Question: Write a single sentence explaining what this figure depicts.
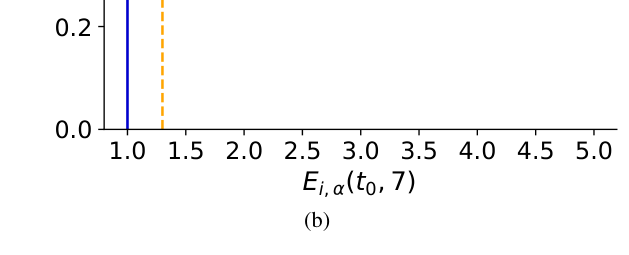
Answer: User-artist engagement threshold choice. (a) User- artist engagement curves as a function of the number of tracks ni,α(t) for different number of days listened tmax within a 7 day period. (b) Cumulative distribution function (ecdf) of the link shares and the associated receiver-artist engagement 7 days post share (Ei,α(t0, 7). The orange line indicates our chosen threshold for a successful share event.